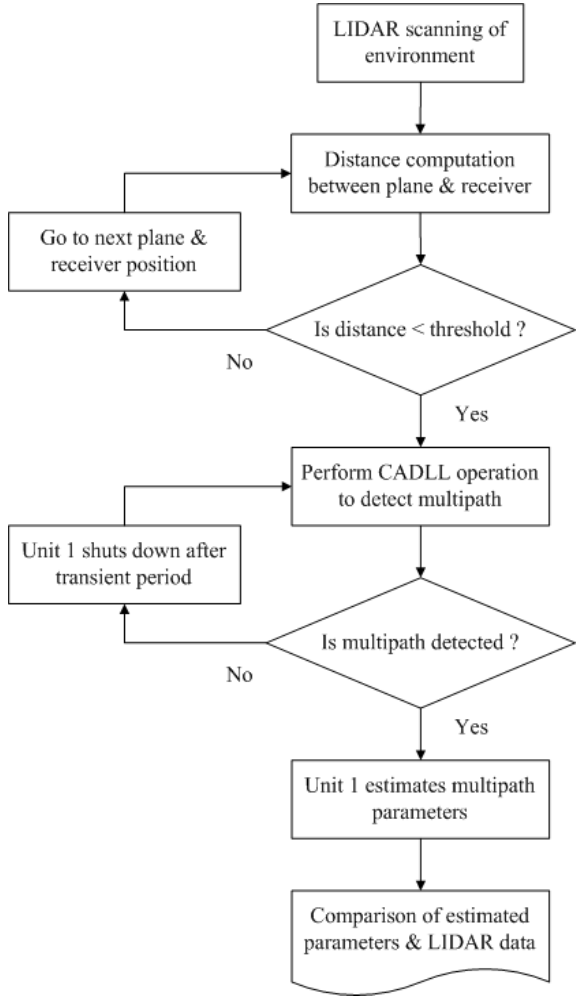
Figure 6. Data processing flow